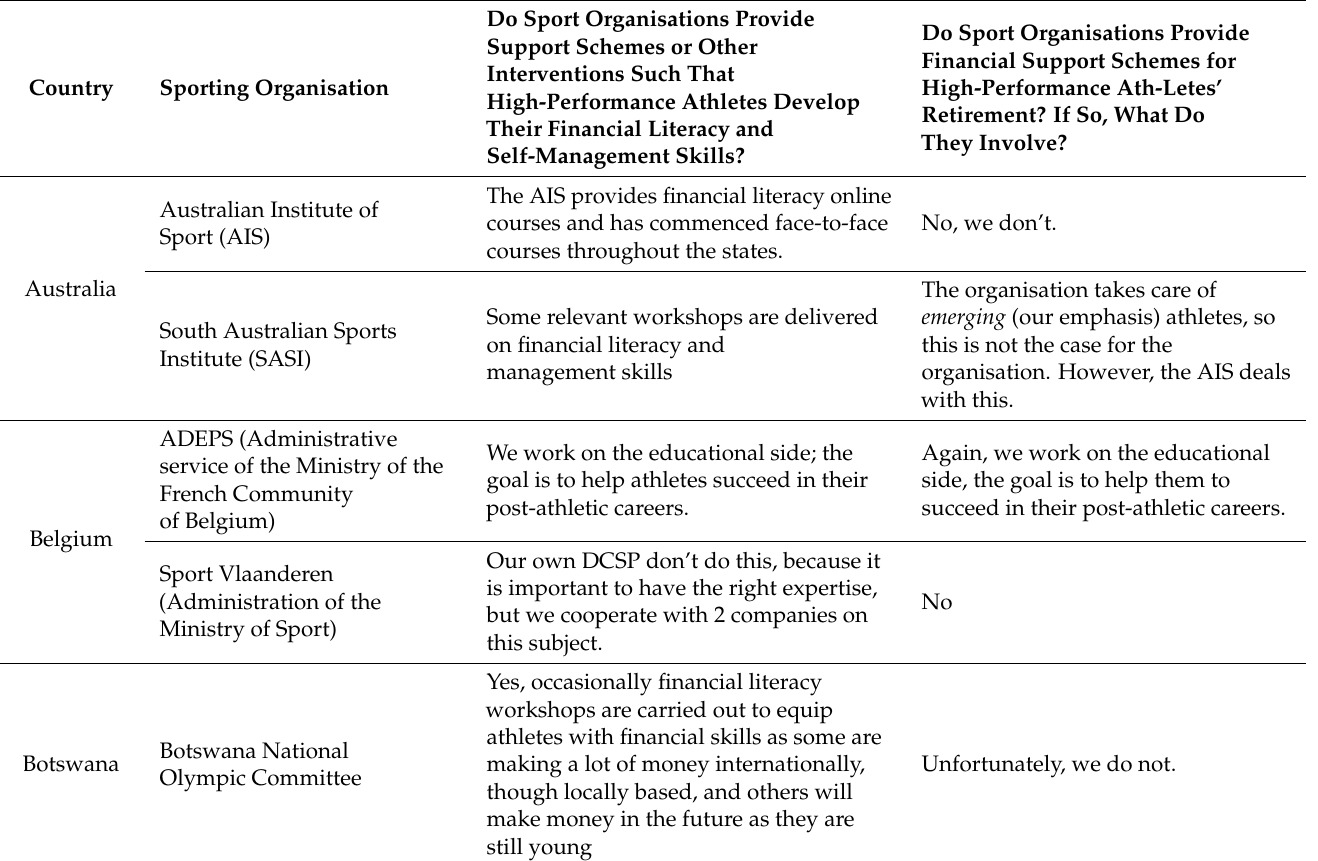
Table 1. Financial planning and support for high performance athletes by country and sport